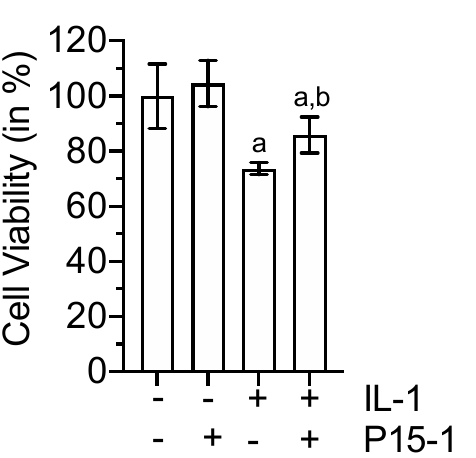
Figure 5. Cell viability of BMSCs cultured in the absence or presence of IL–1 β and P15–1 for 48 h. Cell viability was determined using the CCK–8 viability assay. The absorbance was measured at 460 nm, and the value obtained for vehicle–treated BMSCs was set to 100%. Data were obtained from three different experiments. Values are the mean ± SD. a p < 0.05 vs. vehicle–treated BMSCs; b p < 0.05 vs. IL–1 β –treated BMSCs.